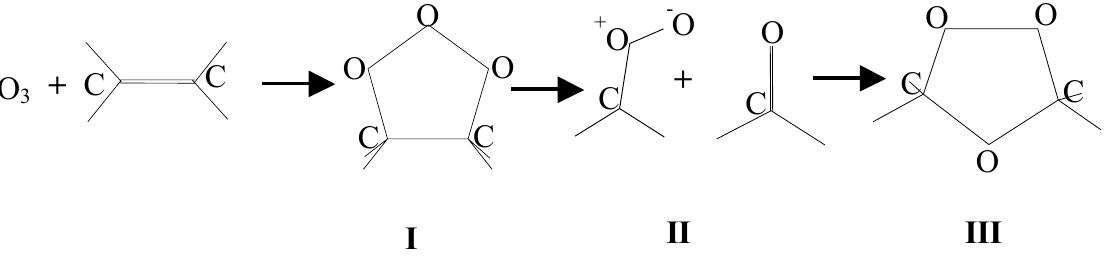
Fig. 1 Schematic representation of Criegee mechanism of ozonization reaction of